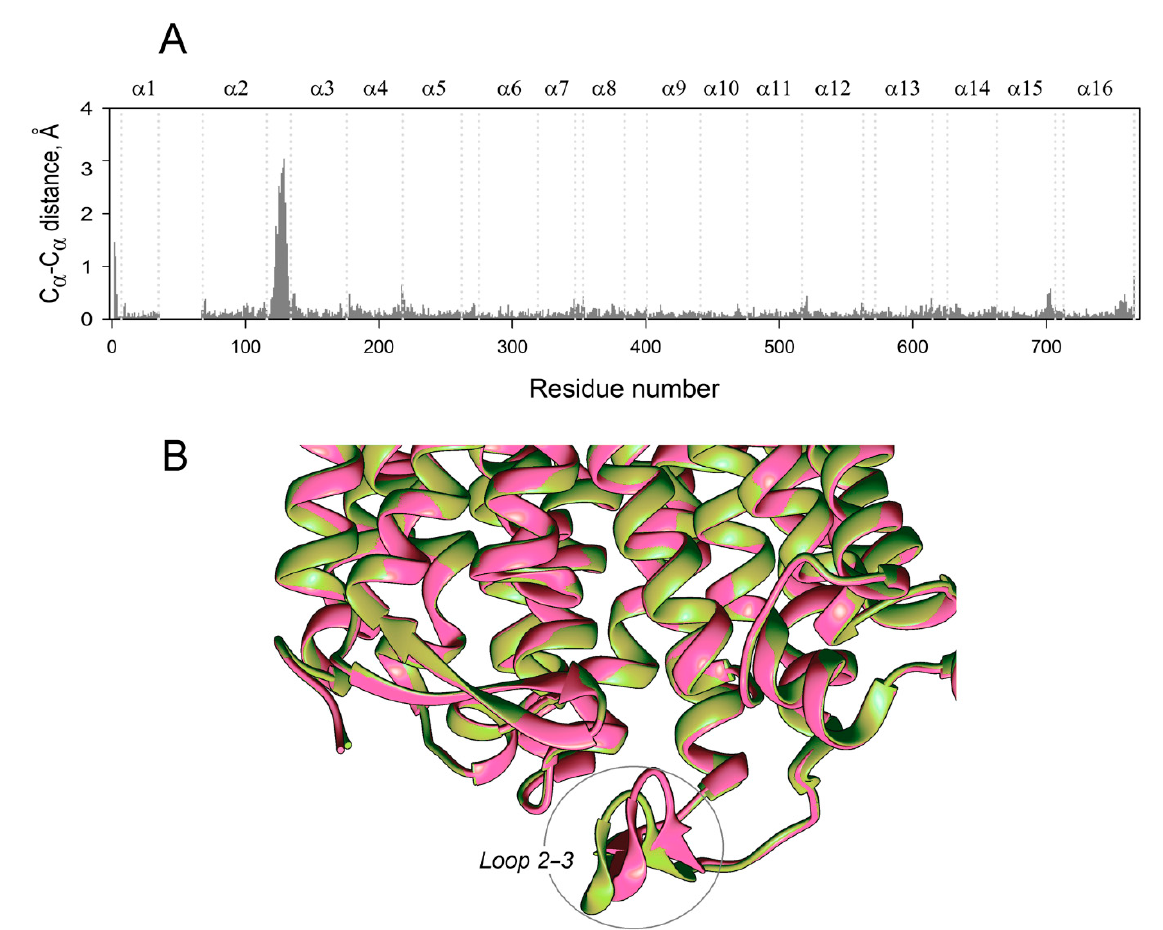
Figure 10. Subunit asymmetry in the published crystal structure of Vr-mPPase containing IDP in both subunits (PDB ID: 4A01) [8]. ( A ) C α atom displacements between superimposed subunit structures. Other notations are as in Figure 2. ( B ) Part of the subunit superposition in the loop 2–3 region. Two subunits are shown in different colors.